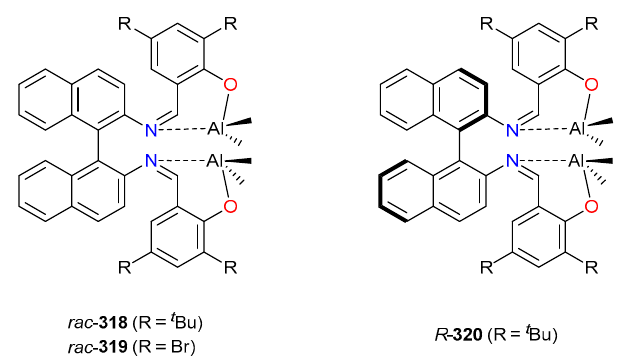
Figure 48. Bimetallic Al complexes supported by binaphthyl- Schiff-base ligands [134].